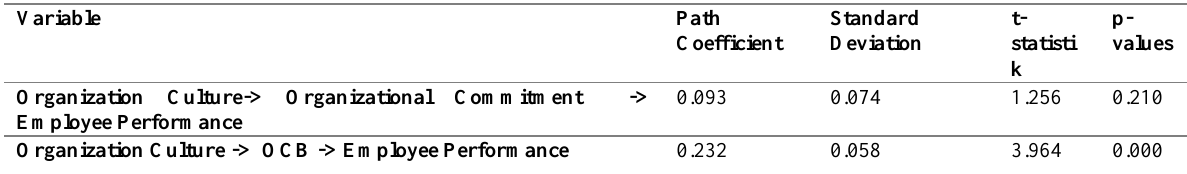
Table 2: Mediation Test